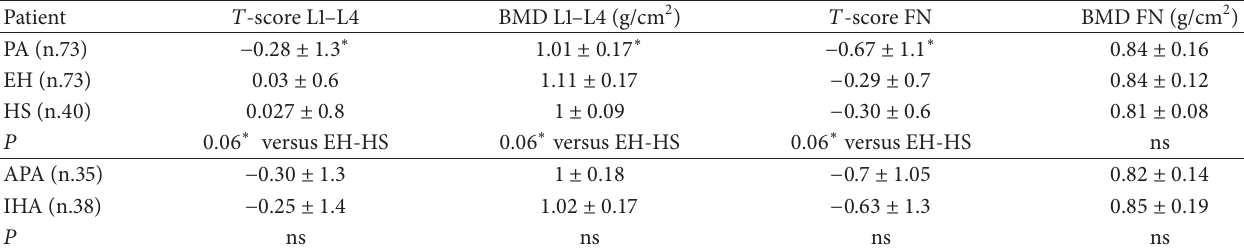
Table 4: Bone mineral density (BMD) evaluated by dual-energy X-ray absorptiometry (DXA) in all subjects enrolled.